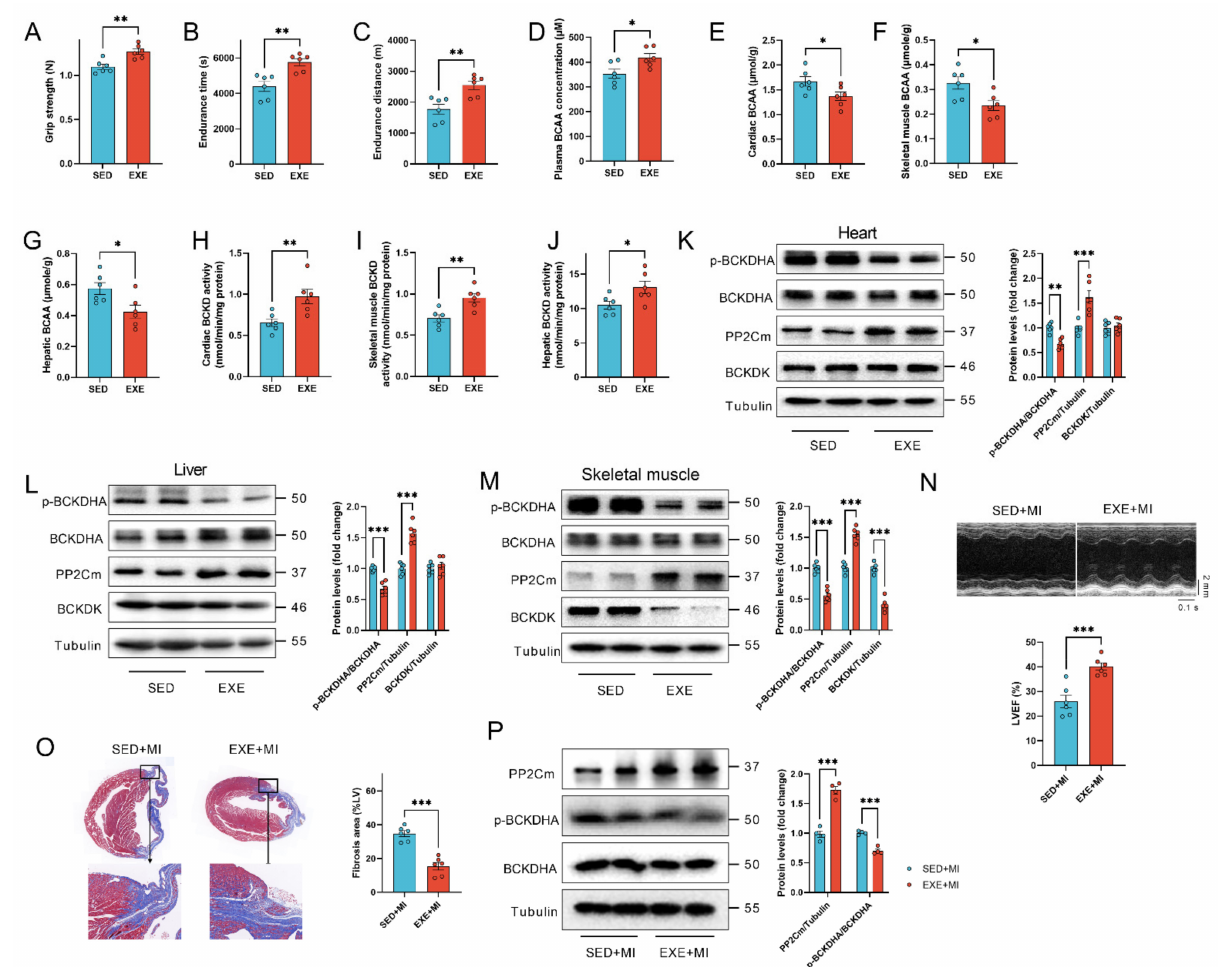
Figure 2. Exercise enhanced cardiac BCAA catabolism in mice. ( A – C ). Exercise increased grip strength ( A ), and treadmill performance ( B , C ) in mice. ( D ). Exercise increased circulating BCAA levels in mice. ( E – G ). Exercise decreased BCAA contents in hearts ( E ), skeletal muscles ( F ) and livers ( G ). ( H – J ). Exercise increased the activity of BCKD in hearts ( H ), skeletal muscles ( I ) and livers ( J ). ( K ). Exercise increased PP2Cm contents and decreased the phosphorylation levels of BCKDHA in hearts. ( L ). Exercise increased PP2Cm contents and decreased the phosphorylation levels of BCKDHA in livers. ( M ). Exercise increased PP2Cm contents, and decreased BCKDHA phosphorylation and BCKDK expression in skeletal muscles. ( N ). Exercise preconditioning increased the left ventricular ejection fraction (LVEF) in MI hearts at 4 weeks post-surgery. ( O ). Exercise preconditioning decreased cardiac fibrosis in MI hearts at 4 weeks post-surgery. The blue staining indicates collagen and fibrosis. ( P ). Exercise preconditioning increased cardiac PP2Cm content and decreased BCDHA phosphorylation in MI hearts at 4 weeks post-surgery ( n = 4). Values are presented as mean ± SEM. n = 6. * p < 0.05; ** p < 0.01; *** p <